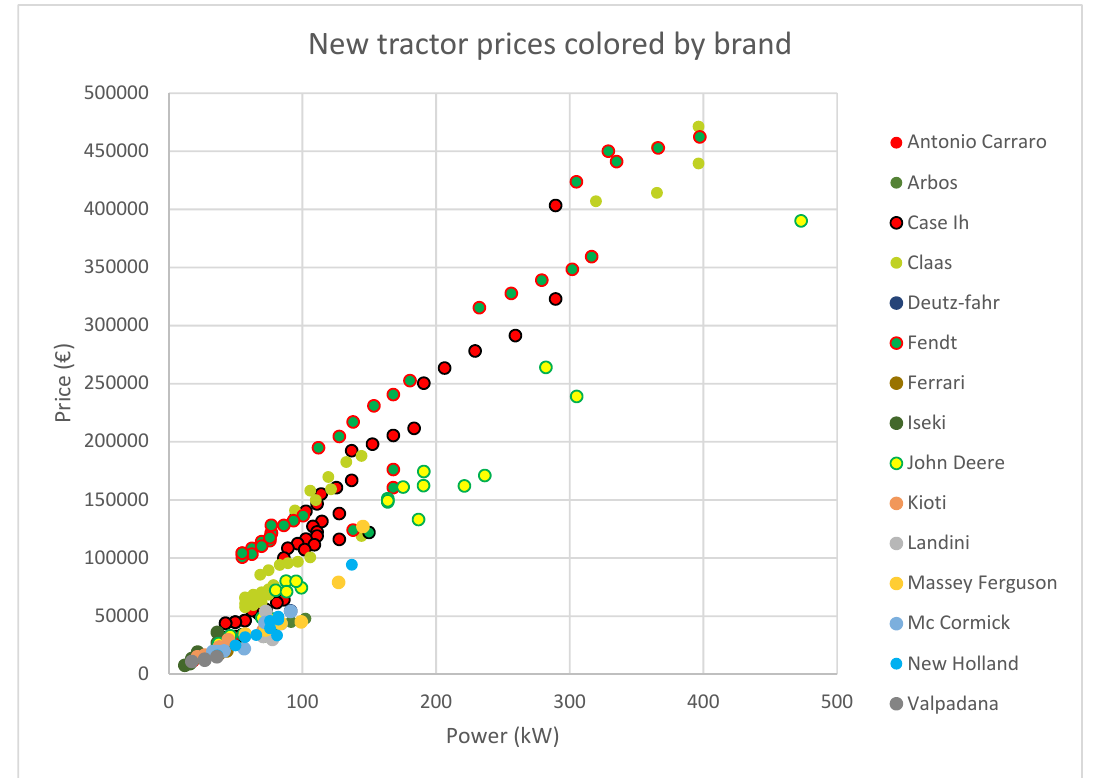
Figure 3. Price vs. power for new tractors.